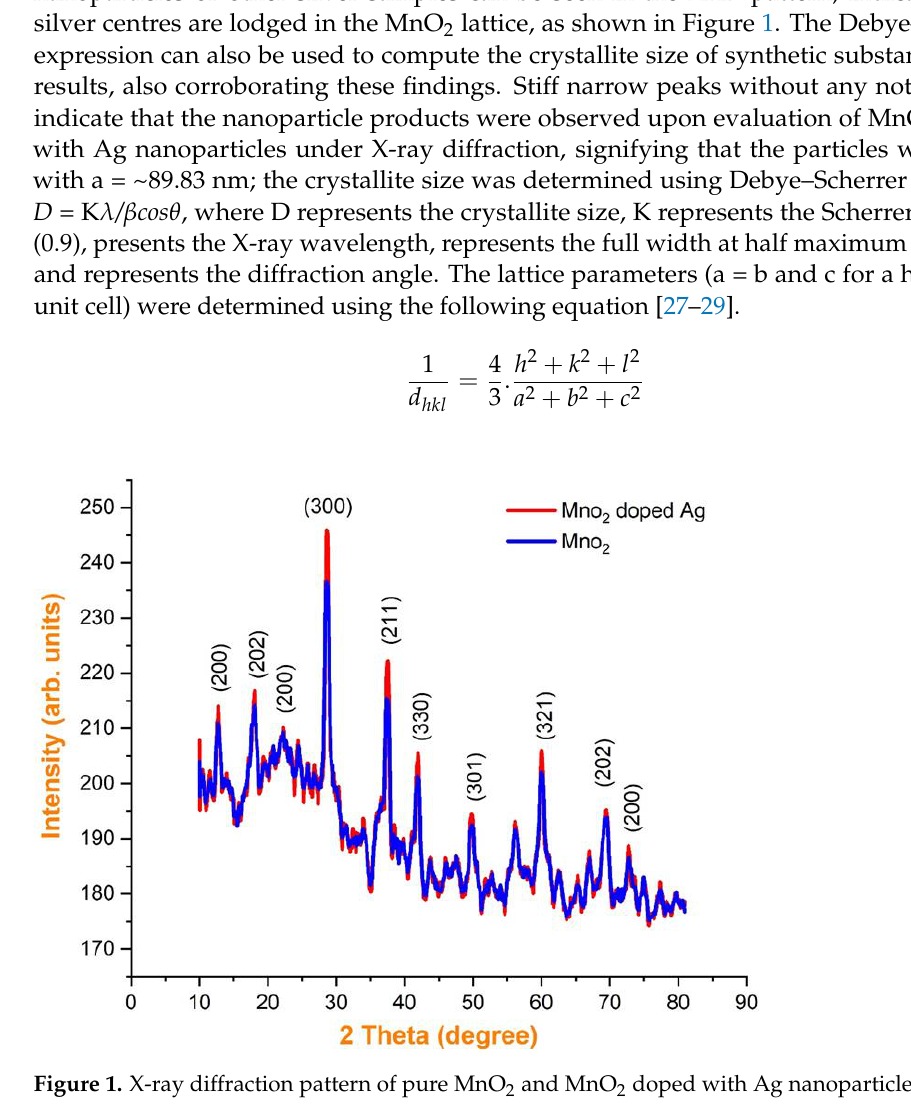
Figure 1. X-ray diffraction pattern of pure MnO 2 and MnO 2 doped with Ag nanoparticles.